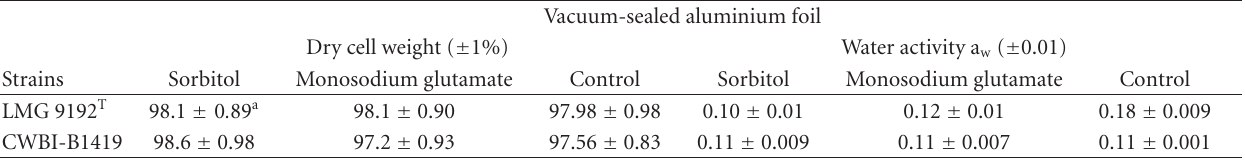
Figure 2: Acidification activity of freeze-dried: (a) L. plantarum CWBI-B1419, (b) L. paracasei ssp . casei LMG 9192 T and (c) control (— (cid:4) —), sorbitol (— (cid:2) —) and monosodium glutamate (— (cid:5) —). Values are presented as means ± standard deviation (SD, n = 4). Table 3: Dry cell weight of freeze-dried cells, conserved at 20 ◦ C and safe from oxygen and moisture. Water activity of freeze-dried cells, conserved at 20 ◦ C and safe from oxygen and